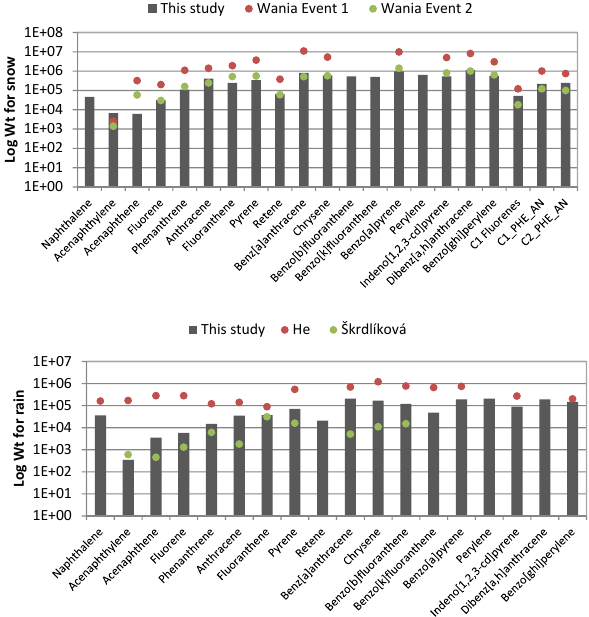
Figure 4. Comparison of total scavenging ratios ( W t ) for snow and rain from this study and the literature (Wania et al., 1999; He and Balasubramanian, 2009; Škrdlíková et al., 2011). PHE_AN =